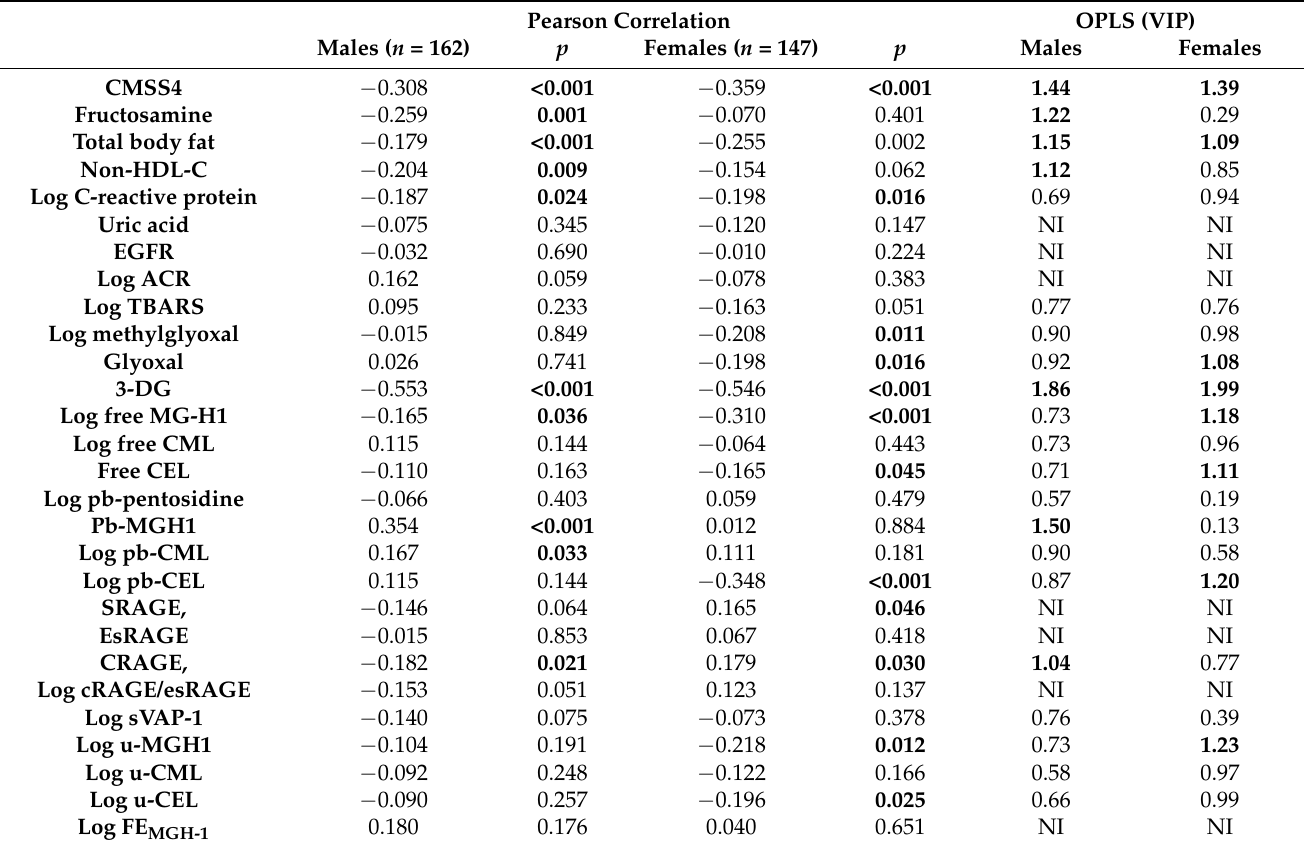
Table 3. Simple regression (Pearson correlation coefficient) and multiple regression using the orthogo- nal projections to latent structures (OPLS) model of independent variables on the quantitative insulin sensitivity check index (QUICKI) in males and